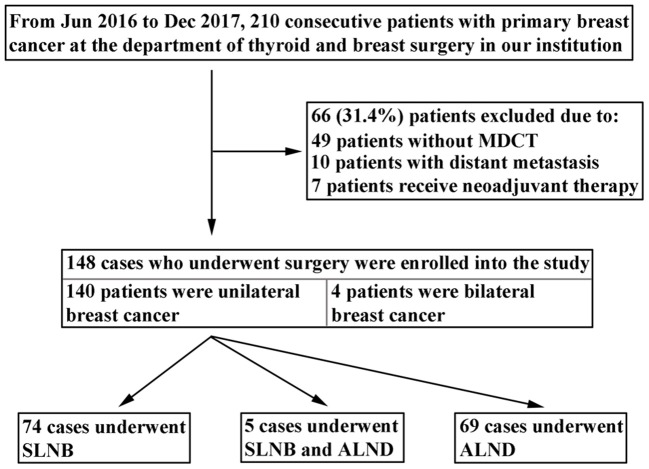
Flowchart of selecting patients with breast cancer.